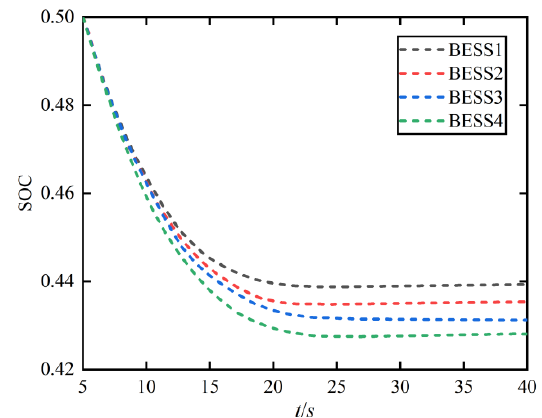
Figure 12. SOC of the BESS.